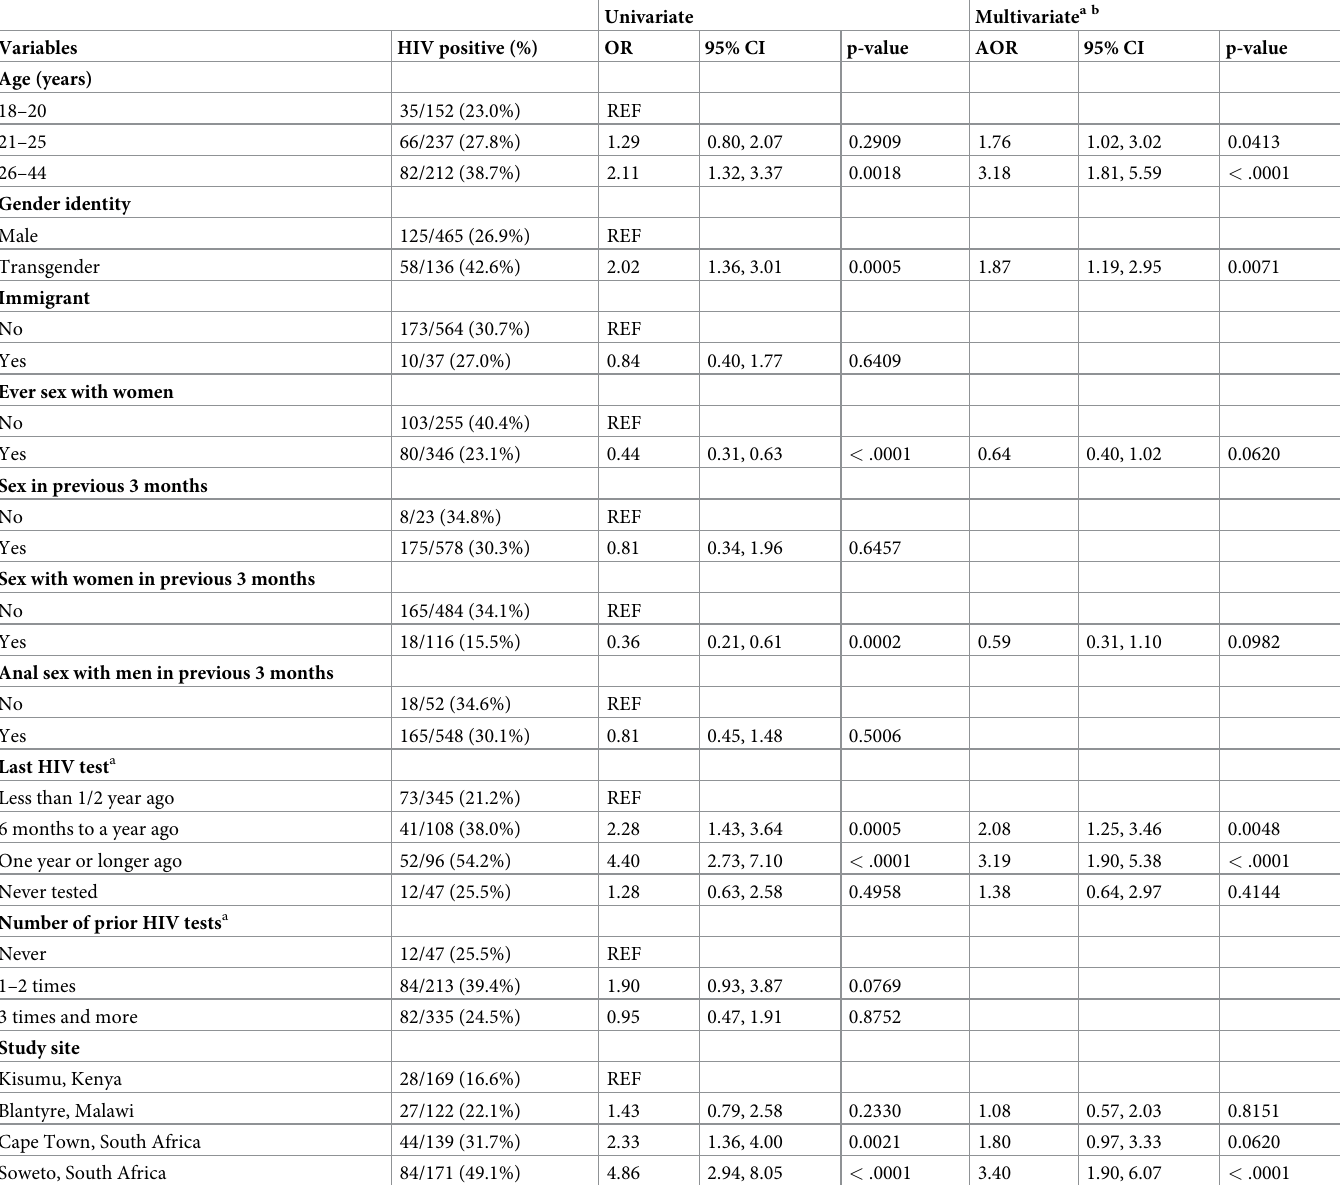
Table 4. Characteristics of HIV-infected vs. HIV-uninfected MSM and TW screened for participation in HPTN 075 (N = 601). Univariate Multivariate a